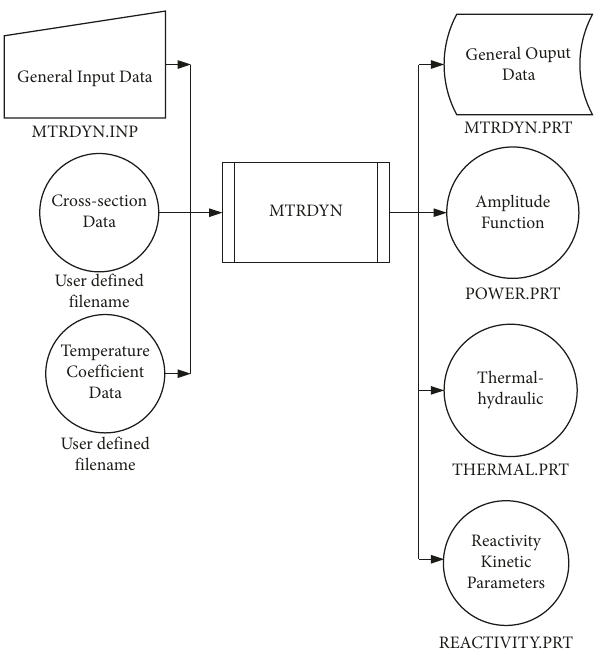
Figure 4: Flow chart diagram for MTR-DYN code